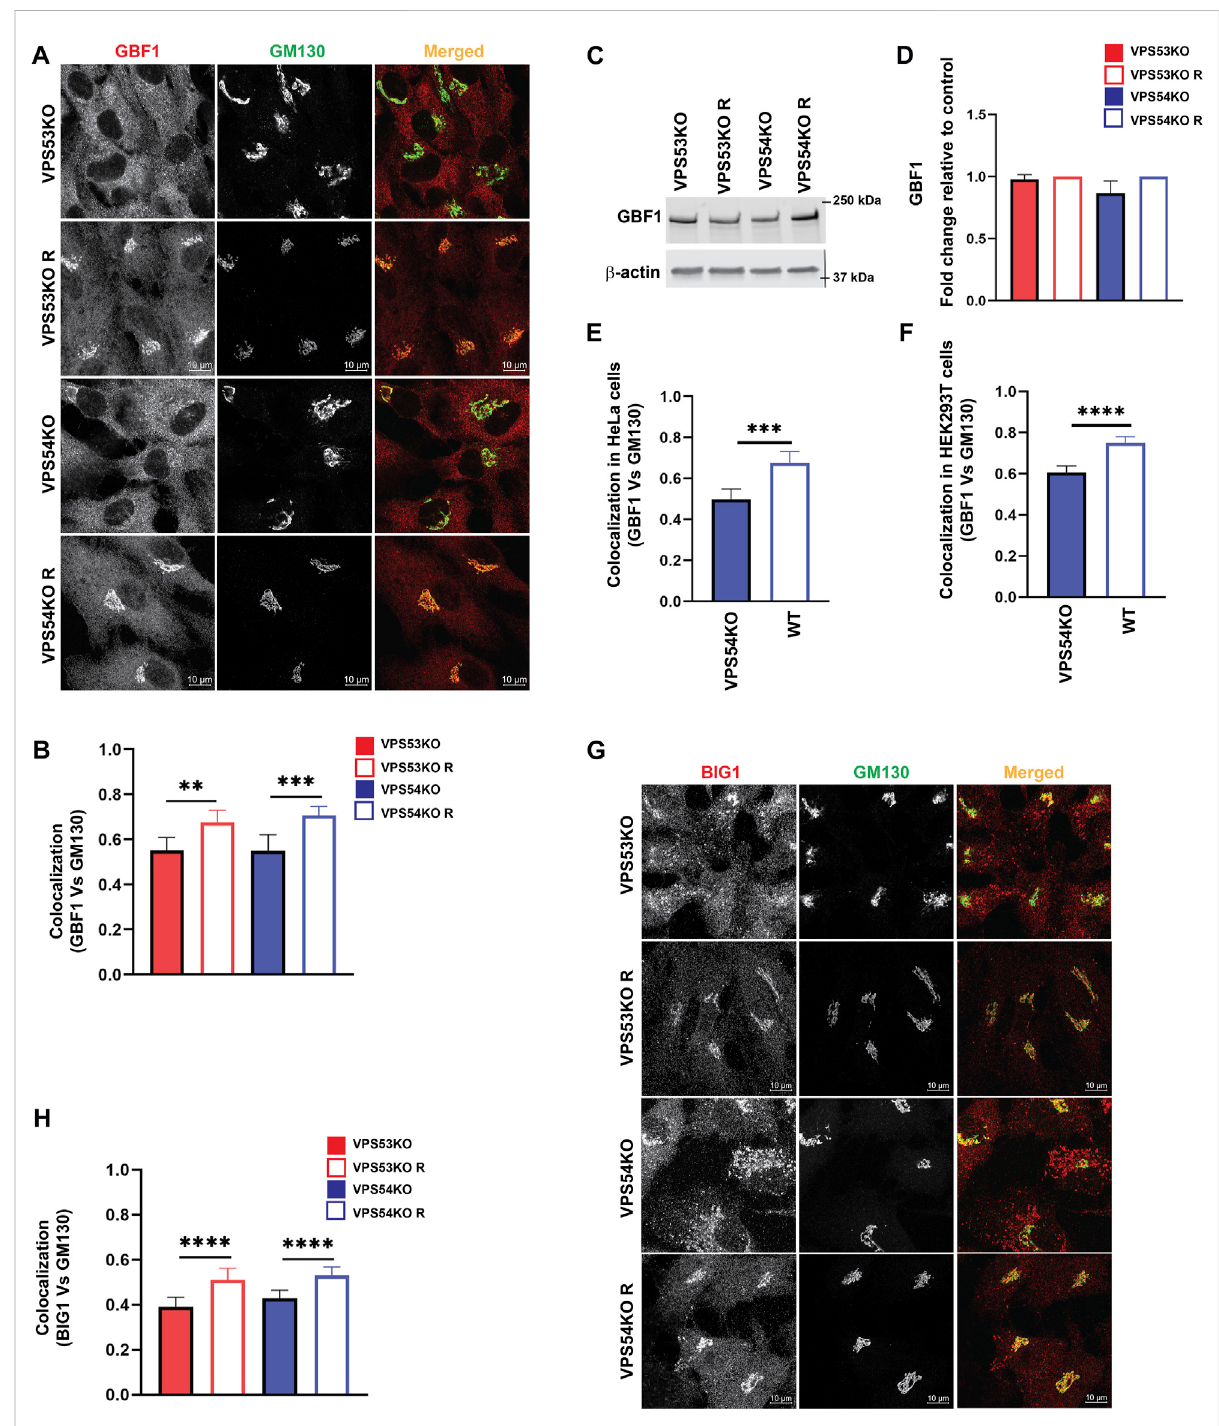
FIGURE 9 ARFGEFsGBF1andBIG1aredisplacedtooff-GolgicompartmentsinGARP-KOcells. (A) AiryscanmicroscopyofGARP-KOandcontrolcellsco- stained with antibodies to GBF1 and GM130 in RPE1 cells. (B) Colocalization analysis of GBF1 and GM130 in RPE1 cells. (C) WB analysis of GBF1 total protein abundance in GARP-KO and control cells. (D) Quanti fi cation of total protein abundance of GBF1 in GARP-KOs and control cells. β -actin was used as the internal loading control. (E) Colocalization analysis of GBF1 and GM130 in HeLa cells. (F) Colocalization analysis of GBF1 and GM130 in HEK293T cells. (G) Airyscan microscopy of GARP-KO and control cells co-stained with antibodies to BIG1 and GM130 in RPE1 cells. (H) ColocalizationanalysisofBIG1andGM130usingPearson ’ scorrelationcoef fi cient. n =50cellswereusedforcolocalizationanalysis.**** p ≤ 0.0001, *** p ≤ 0.001, ** p ≤